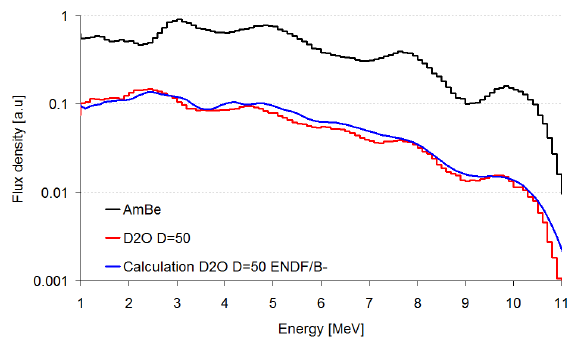
Figure 2. Comparison between leakage spectra calculated with Figure 3. Comparison of calculated and measured leakage flux ISO AmBe spectra and measured spectra. from heavy water sphere of diameter 50 cm with measured AmBe leakage spectra.